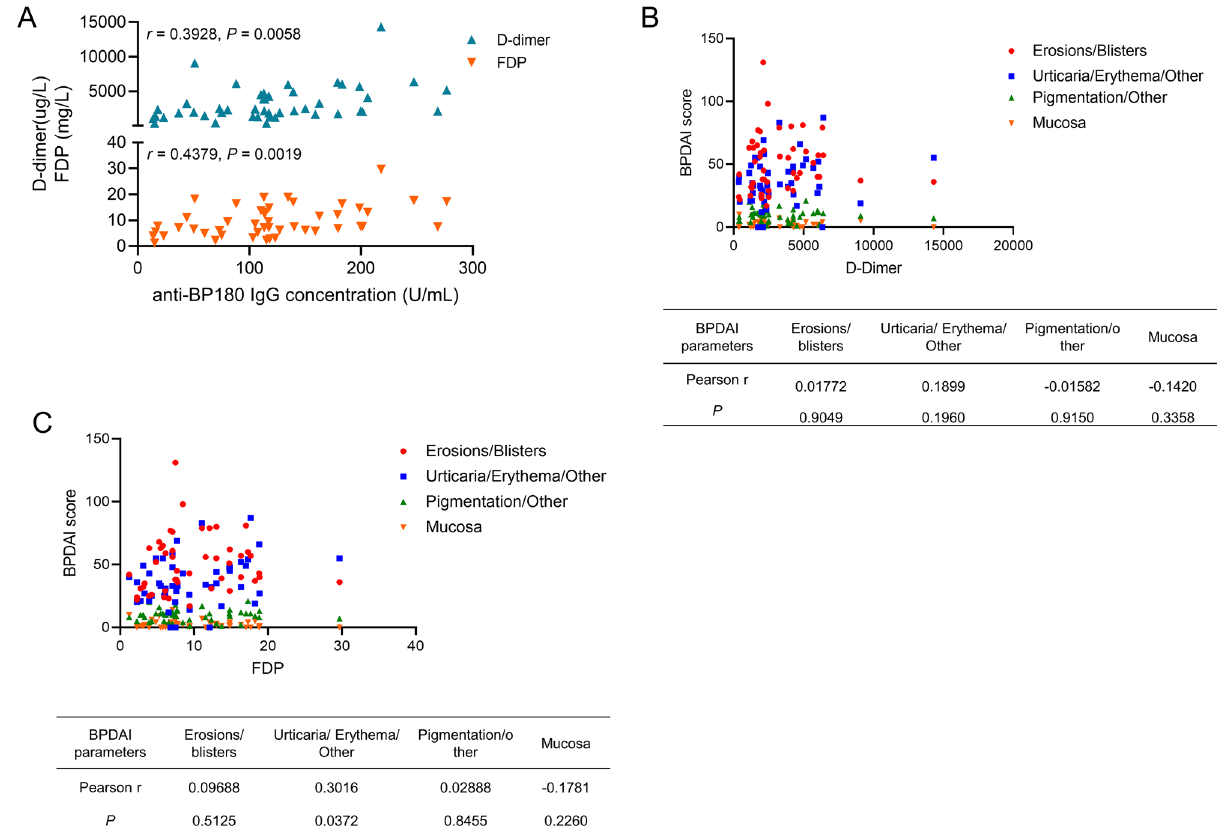
Figure 2. The correlation among D-Dimer, FDP, anti-BP180 IgGconcentrations, and BPDAI. ( A ) The anti-BP180 IgG concentration correlates with the levels of D-dimer and FDP; ( B and C ) The correlation between the levels of D-dimer and FDP and